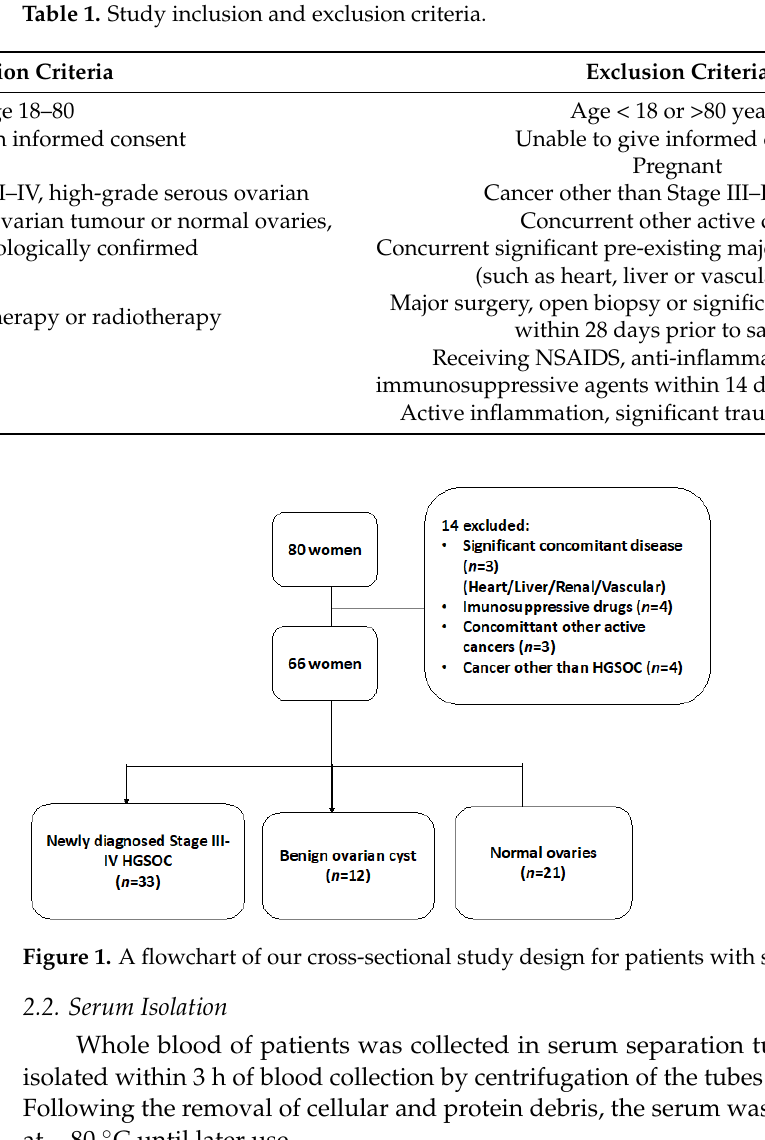
Table 2. Characteristics of study patients according to tumour status.